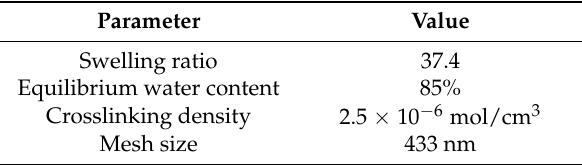
Table 1. Mesh structure parameters of 2 HA-MA